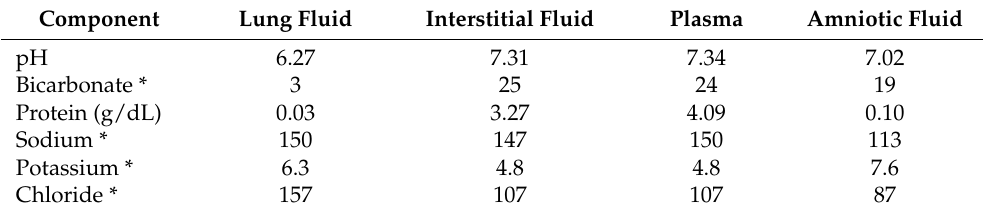
Table 1. Composition of Bodily Fluids Compared to Lung Fluid. * (mEq/L). Adapted from Plosa and Guttentag, Lung Development in Avery 10th Edition [20] and Bland R